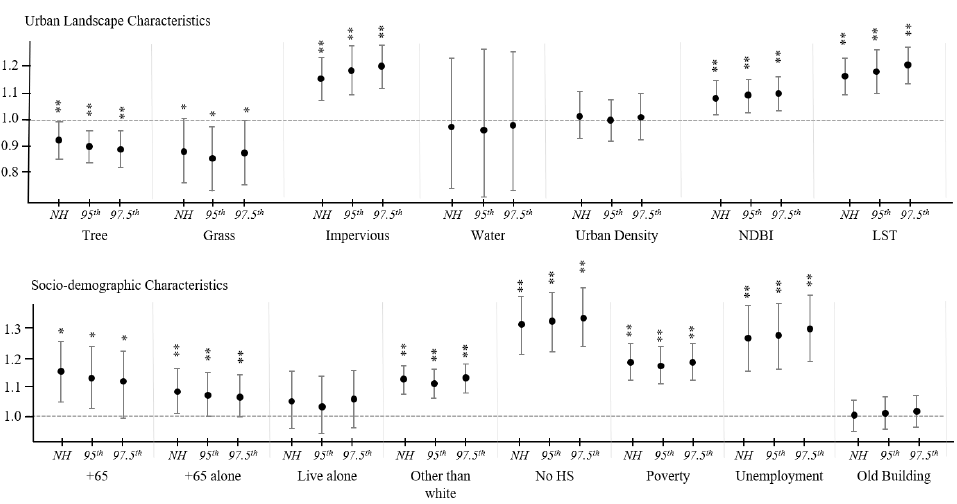
Figure 2. Odds ratios (ORs) and 95% confidence intervals for normal, 95th extreme, and 97.5th extreme heat days (** p < 0.01, * 0.01 ≤ p < 0.05).